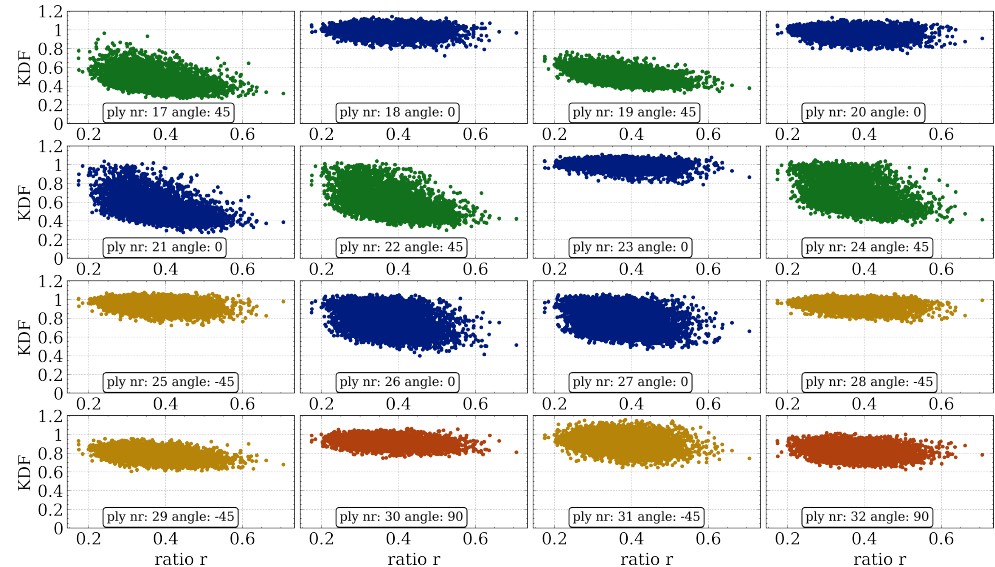
Figure 13. Scatter plot of waviness ratio compared to resulting KDF for property R x . Plies that share the same fiber orientation angle are colored equally.